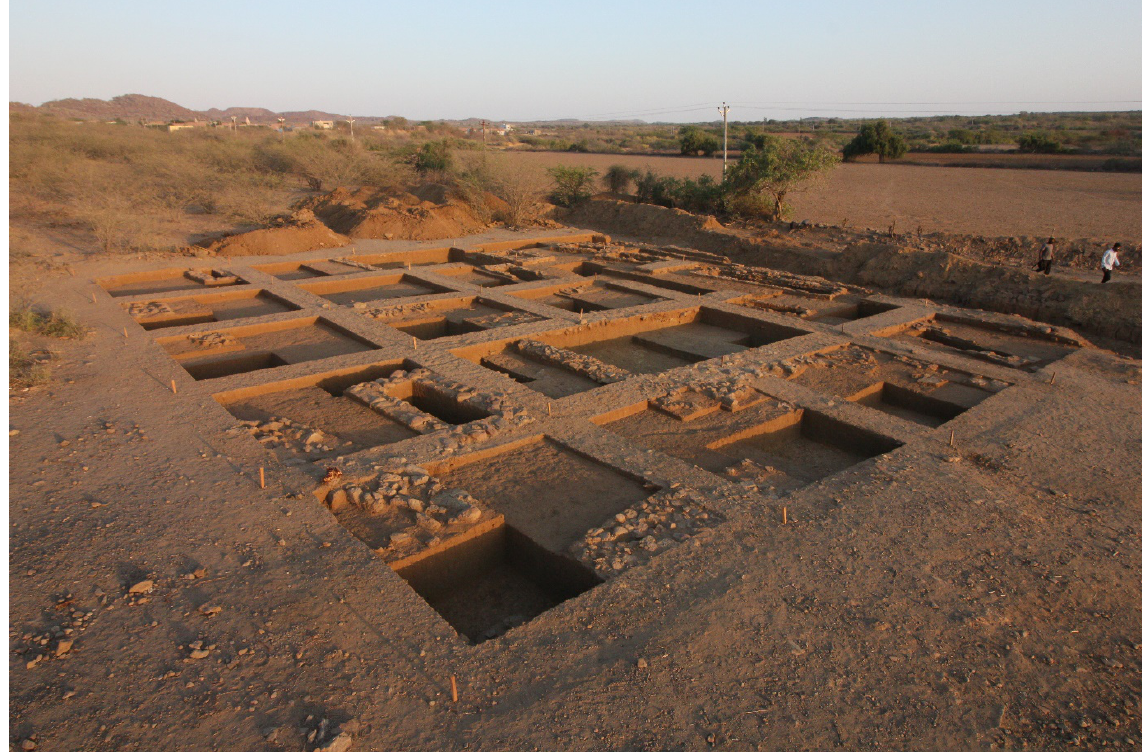
Figure 2: Excavated burials at Juna Khatiya (P.C. Department of Archaeology, University of